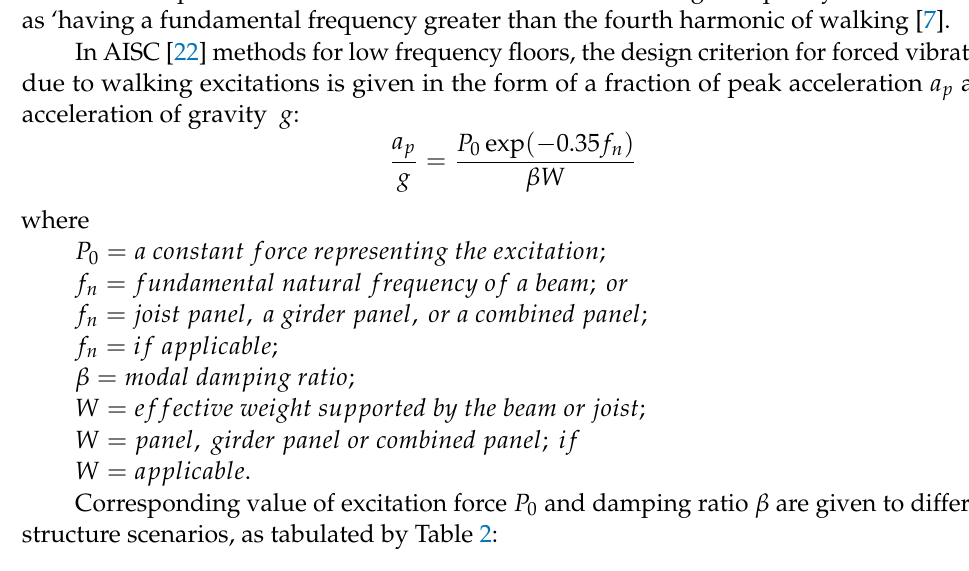
Table 2. Recommended Values of Parameters in Equation (4) and a p